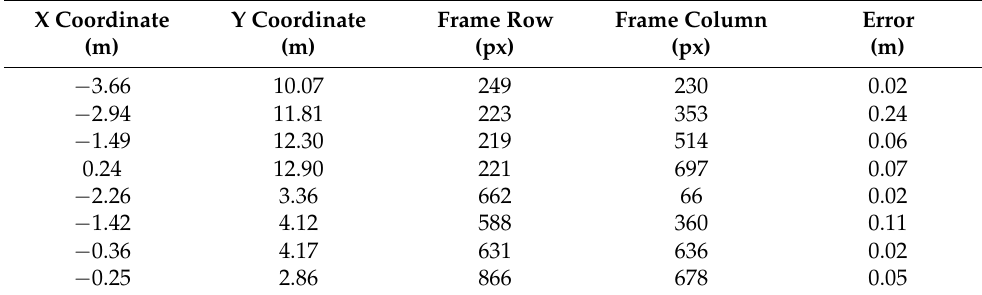
Table A4. GCP of Loussios river case study upstream Atsicholos